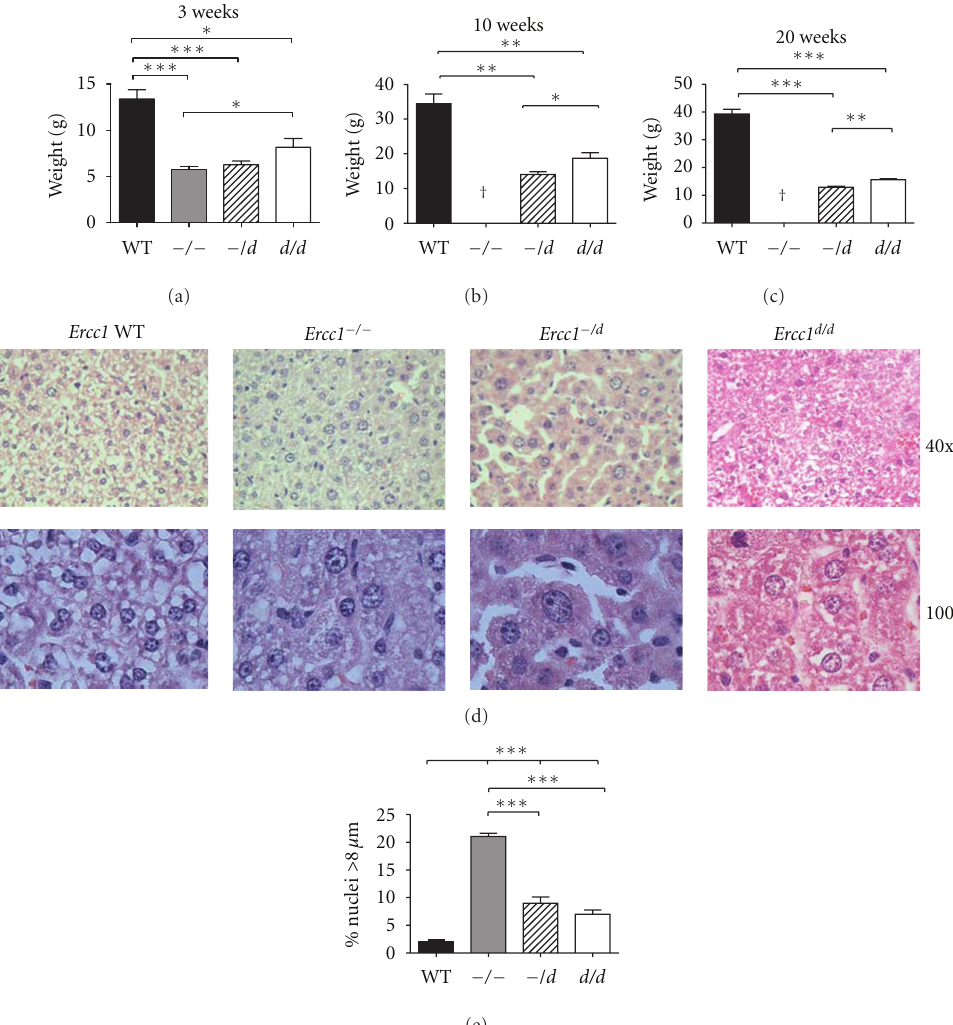
Figure 2: Weight and liver cell morphology of mice with distinct levels of Ercc1 activity. ((a)–(c)) Mean body weight of (a) 3-week-old Ercc1 − / − ( n = 6), Ercc1 − /d ( n = 7), Ercc1 d/d ( n = 4), and wt ( n = 13) mice. (b) 10-week-old Ercc1 d/d ( n = 3), Ercc1 − /d ( n = 3), and wt ( n = 6) mice. (c) 20-week-old Ercc1 − /d ( n = 8), Ercc1 d/d ( n = 5), and wt ( n = 12) mice. (d) Hematoxylin- and eosin-stained sections of liver from 3-week-old wt, Ercc1 − / − , Ercc1 − /d , and Ercc1 d/d mice. (e) Quantification of enlarged nuclei ( > 8 μ m). Error bars indicate standard deviation. ∗ indicates P ≤ 0 . 05, ∗∗ indicates P ≤ 0 . 01, and ∗∗∗ indicates P ≤ 0 . 001. megakaryocyte-erythroid progenitors (MEP, Lin − cKit+ CD34 − CD16/CD32low), and common lymphoid progen- itors (CLP, Lin − CD127+ Sca1/cKit+ int). At 3 weeks of age, the CMP fraction of Ercc1 − / − mice decreased to 46% of wt, the GMP fraction to 16% of wt, the MEP fraction to 45% of wt, and the CLP fraction to 48% of wt levels (Figure 3(g)). In Ercc1 − /d mice, the progenitor